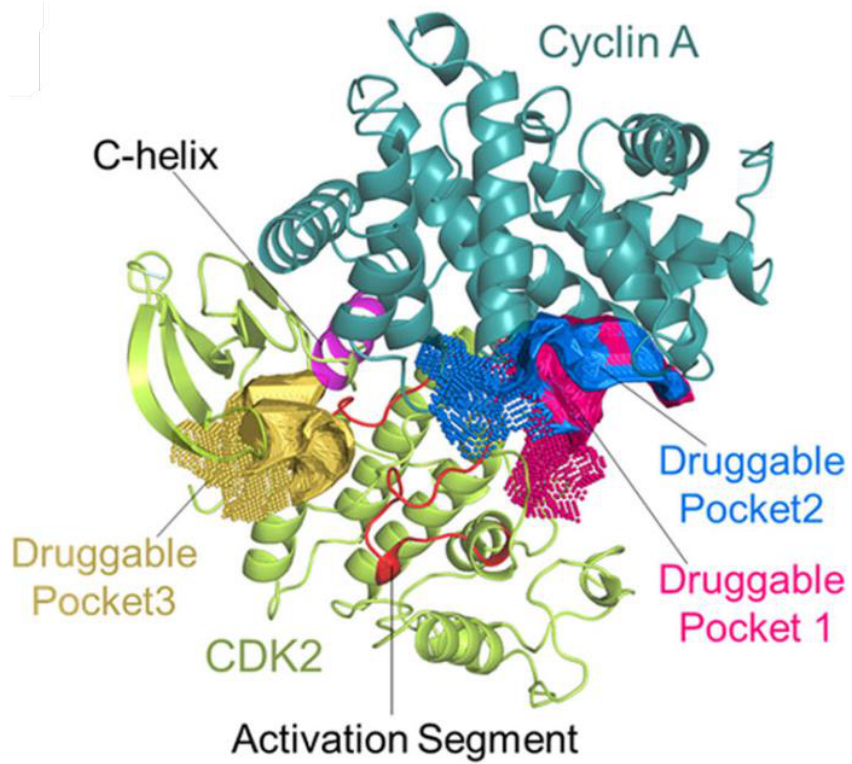
Figure 2. The 3D structure of CDK2/Cyclin A with druggable pockets labeled with permission [24].